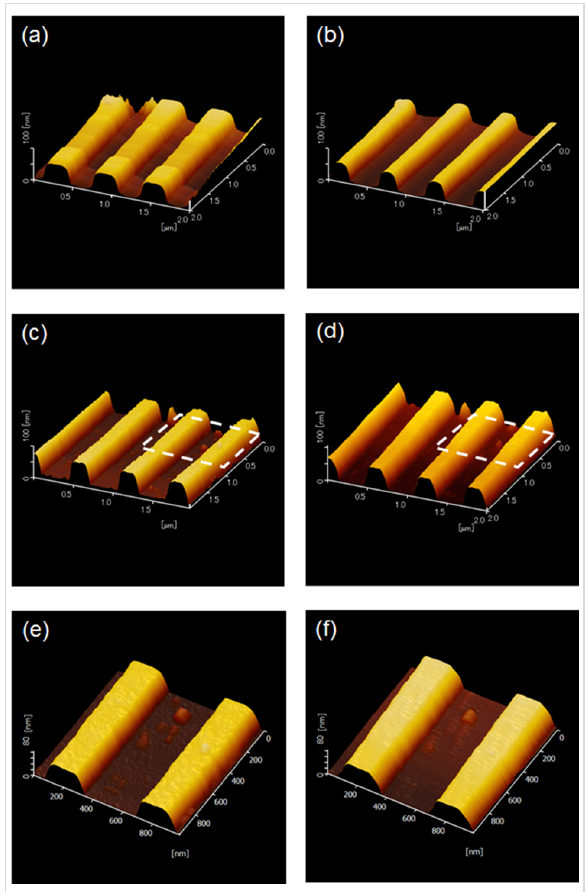
Figure 1: AFM images of the photoresist after 120 min of near-field etching with a He–Cd laser (325 nm, 3.81 eV) ((a) before and (b) after) and a GaN laser (405 nm; 3.06 eV) ((c) before and (d) after). (e) and (f) provide details of (c) and (d) respectively at the same positions (white dashed